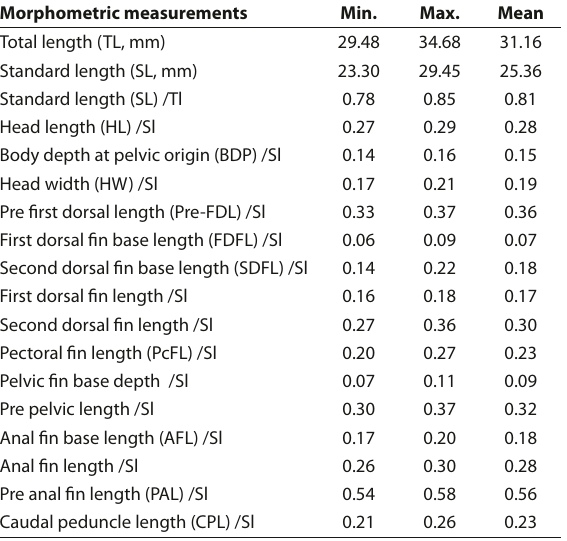
Table 1. Morphometric characters of 4 specimens of F. reichei col- lected from the Coast of Makran Sea. All values except for total length (TL) and standard length (SL) are